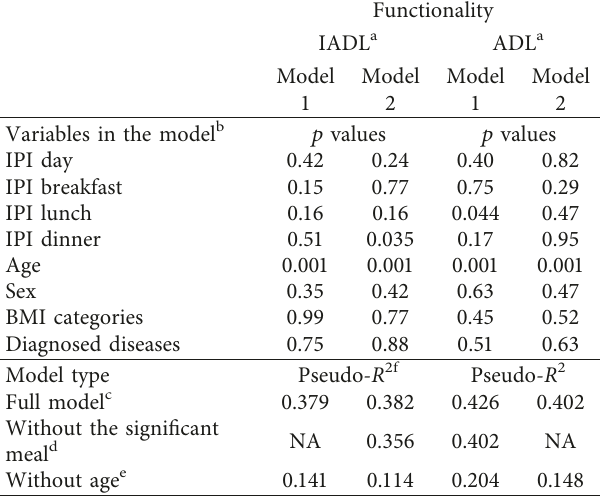
a Outcome variable. b Independent variables. c Included all listed variables. d Included all variables except the IPI at the meal with a significant p value. e Included all variables except the age. f Nagelkerke pseudo- R 2 . ADL: ac-